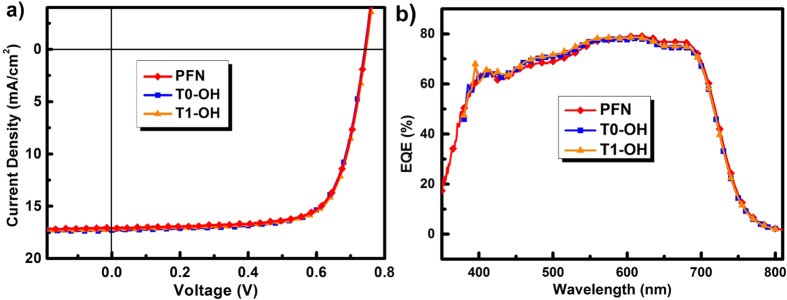
(a) J-V characteristics and (b) EQE spectra of the inverted PSCs with PTB7:PC71BM as the active layer and T0-OH, T1-OH or PFN as the cathode interlayer, with a device structure of ITO/interlayer/PTB7:PC71BM/MoO3/Al.